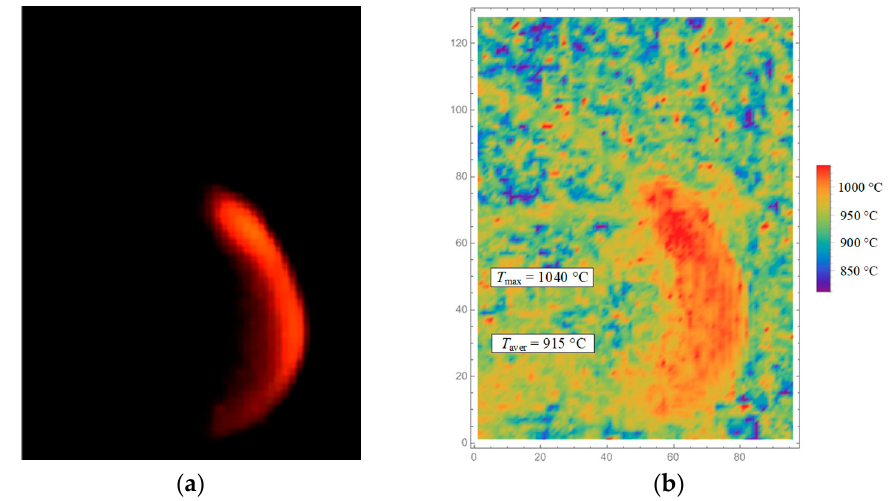
Figure 2. Video frames of a fuel droplet burning ( a ) and a temperature field based on it ( b ).